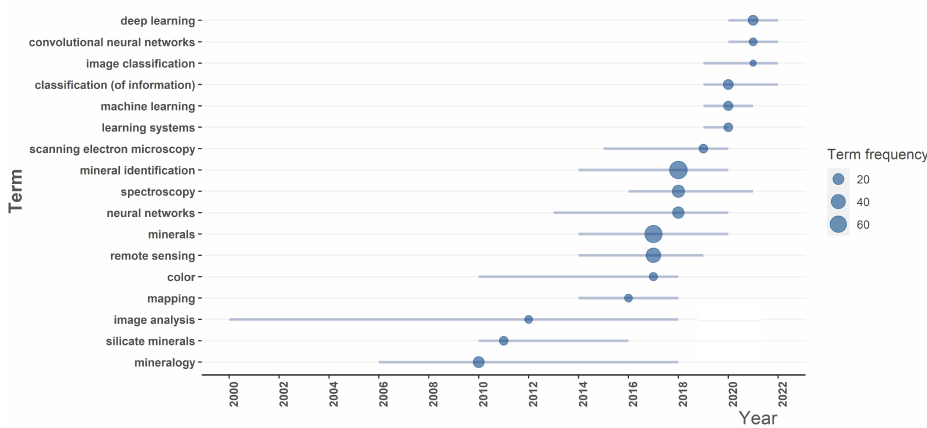
Figure 3. Keyword emergence detection results.